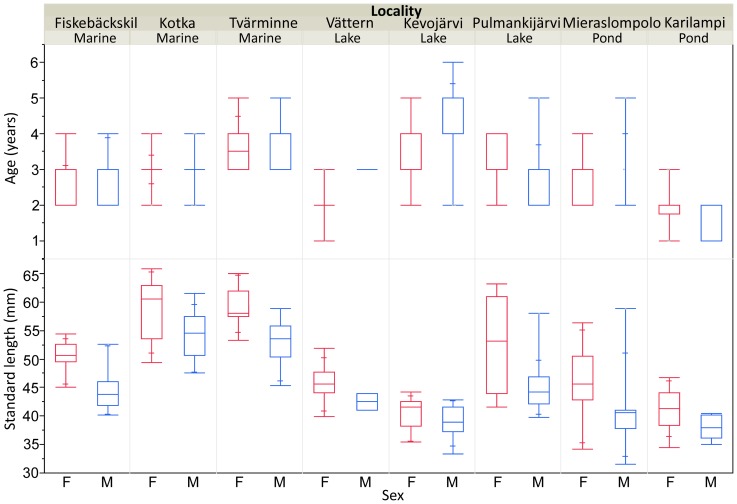
Box-plots of (a) age and (b) standard length of female and male three-spined sticklebacks in eight different localities arranged by habitat type.The boxes depict the first and third quartiles and band within boxes the median. Maximum and minimum data values are depicted by whiskers with wide bars, the narrower bars depicting 10% and 90% quartile ranges. For sample sizes, see Table 1.